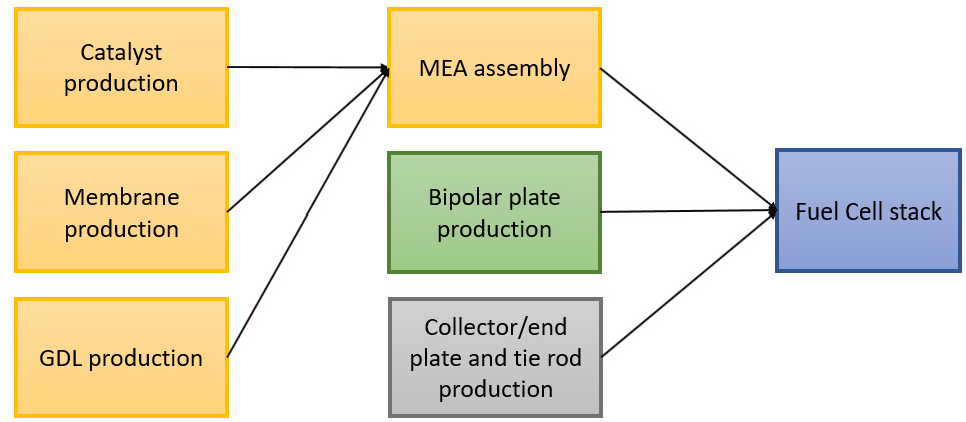
Figure 2. Scheme of the components to assembly a fuel cell stack.